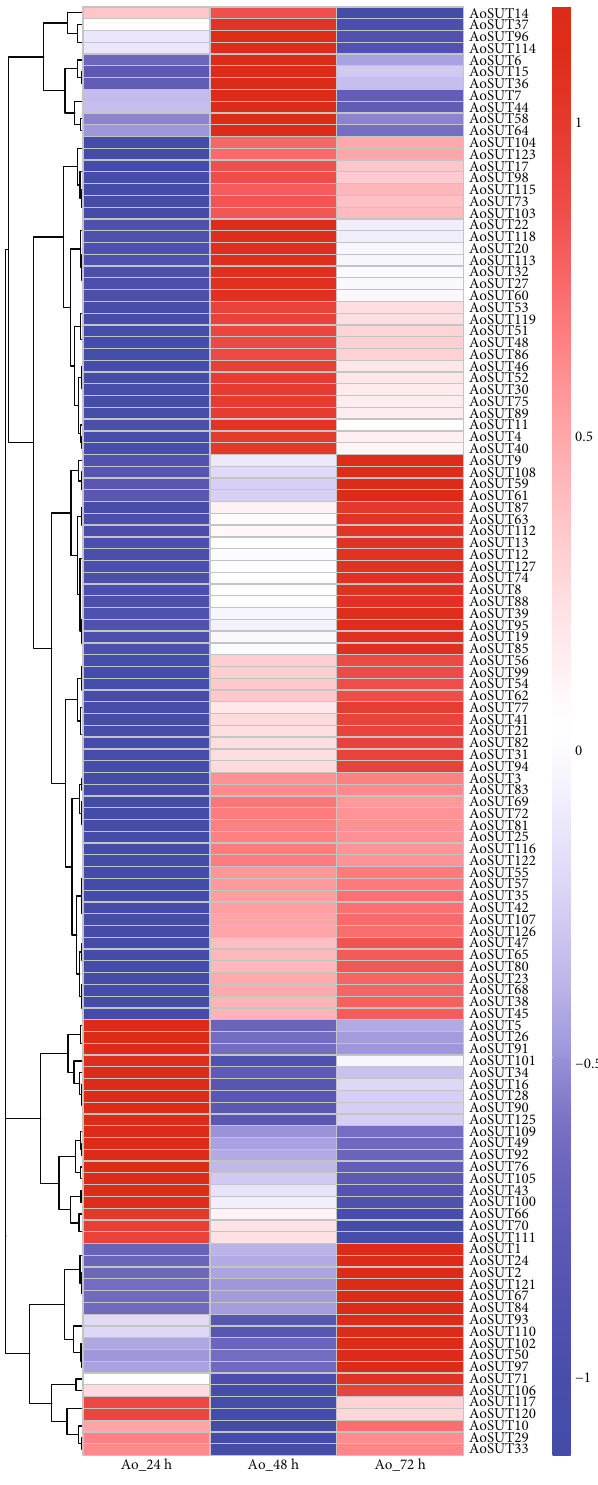
Figure 4: Expression pro fi les of AoSUT genes at di ff erent stages of development. Ao_24_48_72h indicated the expression level of AoSUT at 24h, 48h, and 72 h (corresponding to lag phase, logarithmic phase, and stationary phase, respectively). The color of the scale bar, ranging from blue to red, represents low and high expressions,